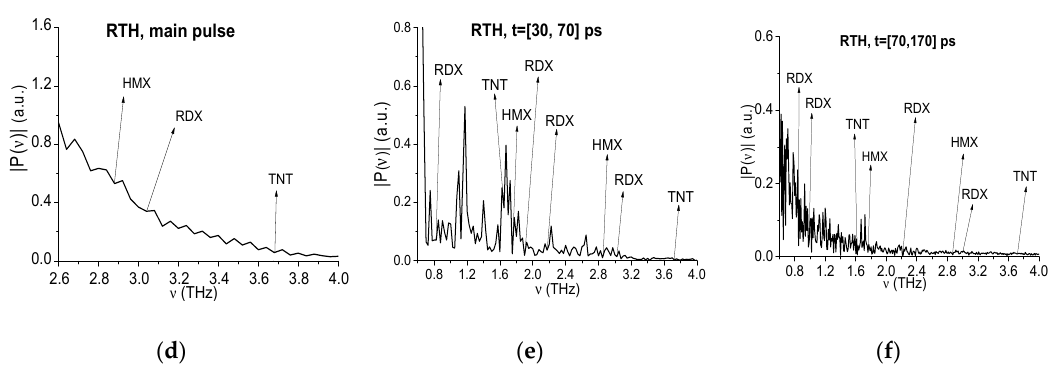
Figure 27. RTH signal in the time intervals t = [0, 25] ps ( a ), [30, 70] ps ( b ), and [70, 170] ( c ). Spectra of the main pulse ( d ), first sub-pulse ( e ) and the remote part of the RTH signal ( f ) with absorption frequencies of RDX, HMX, and TNT detected by the ICCs in the frequency ranges ν = [2.6, 4.0] THz ( d ), [0.6, 4.0] THz ( e,f ).